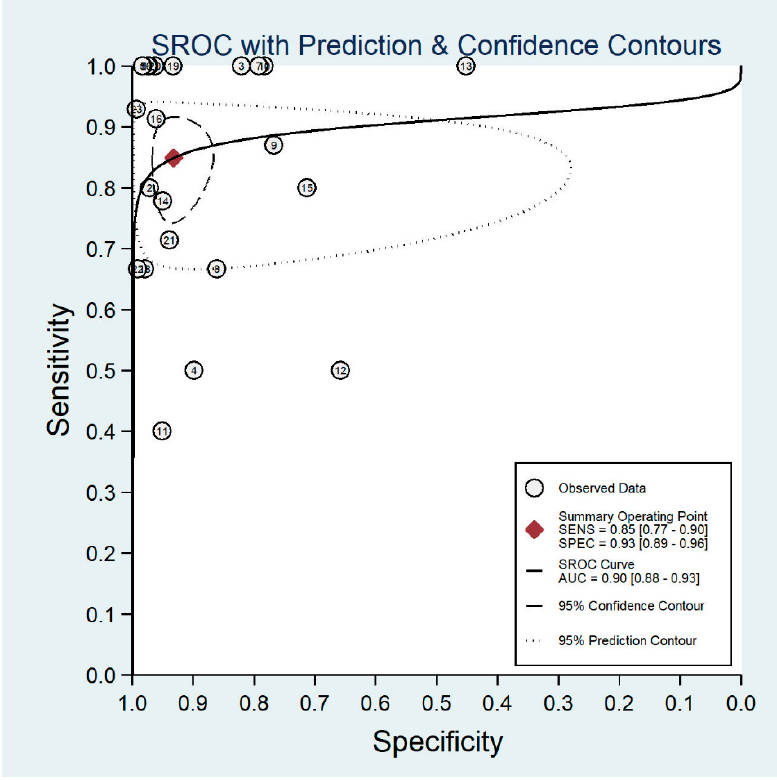
Figure 7. Receiver operating characteristic curve for non-mydriatic fundus imaging.